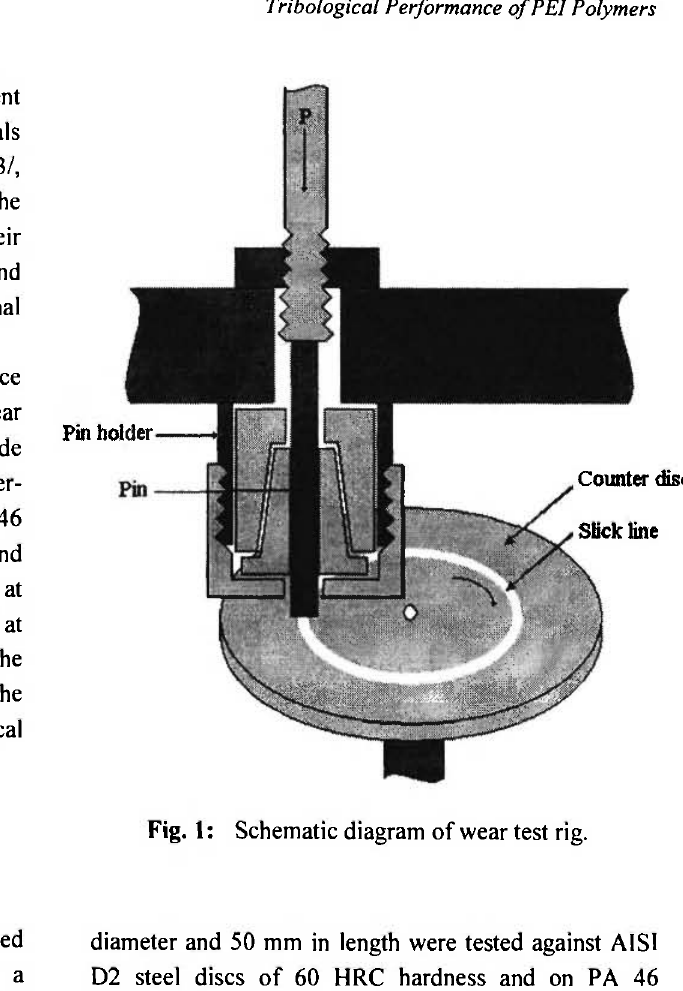
Table I. Table II presents the physical and mechanical properties of PEI polymer used in this work. The losses in pin weight were measured after 1 km sliding